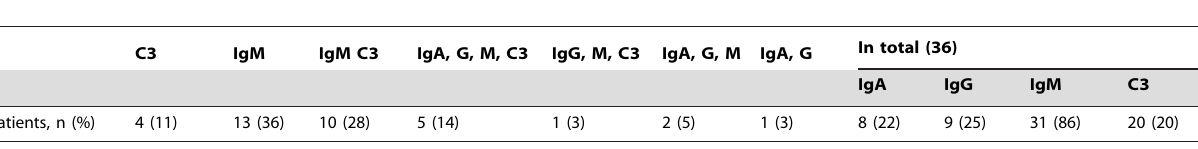
Table 1. Patterns of immunoreactants in the lesional skin of patients with SLE.